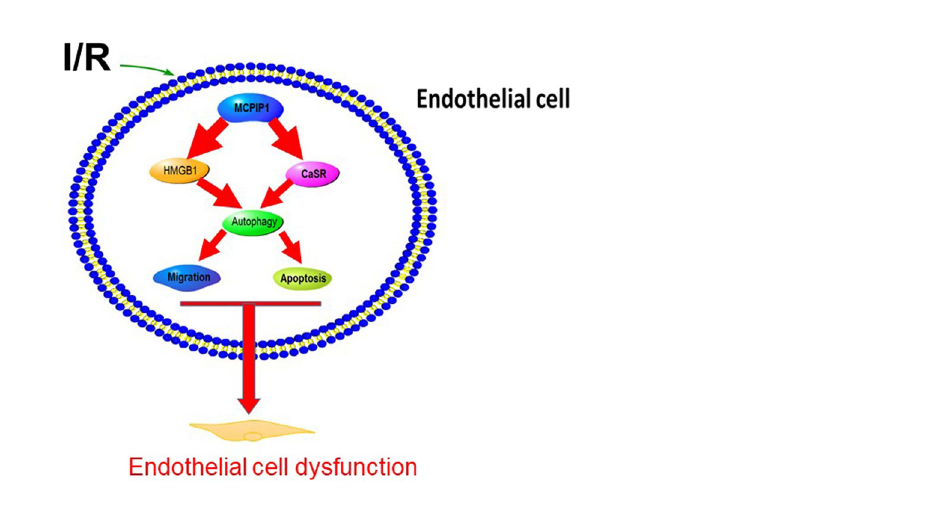
is consistent with previous studies of HMGB1 and cell migration 52–54 , HMGB1 did not have an effect on cell via- bility. However, contradictory reports have been published regarding the role of HMGB1 in apoptosis in different cell types. HMGB1 exerts a protective effect on cardiomyocytes, but it also induces endothelial progenitor cell